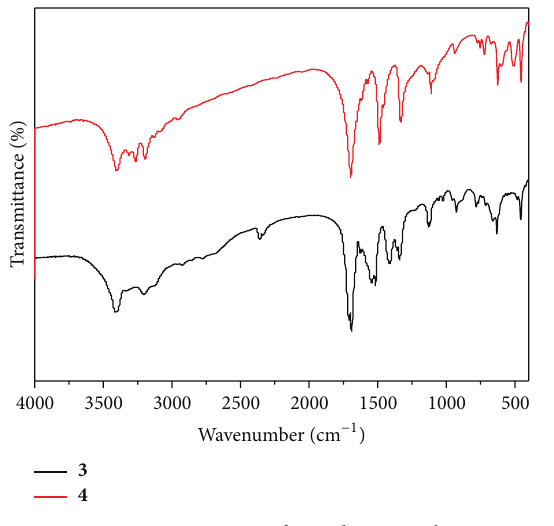
Figure 3: IR spectra of complexes 3 and 4 .